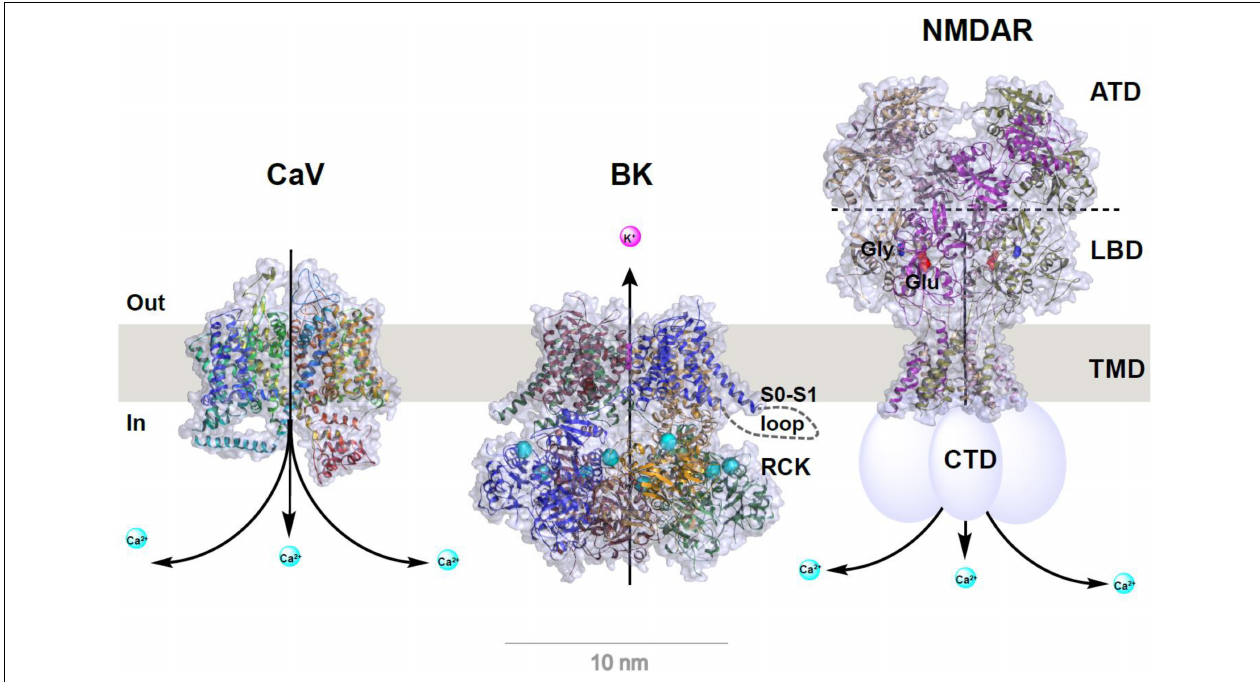
FIGURE 1 | Structural models of Ca V and BK channels and NMDA receptor. Structures were redrawn from published structures of rabbit Ca V 1.1 (PDB ID: 5GJV) (Wu et al., 2016), human BK (PDB ID: 6V22) (Tao and MacKinnon, 2019), and rat GluN1a/GluN2B NMDA receptor (PDB ID: 4PE5) (Karakas and Furukawa, 2014). For clarity, auxiliary subunits of Ca V and BK channels are omitted and the bound Ca 2 + ions in BK channel’s RCK domains are shown as enlarged cyan balls. Depiction in cartoon was added manually for the S0–S1 loop (only on one subunit) of BK channel and C-terminal domain (CTD) of NMDA receptor whose structures were unresolved. For NMDA receptor, the amino terminal domain (ATD), ligand binding domain (LBD), transmembrane domain (TMD), the bound glutamate (Glu) and glycine (Gly) are indicated on or near the corresponding structural